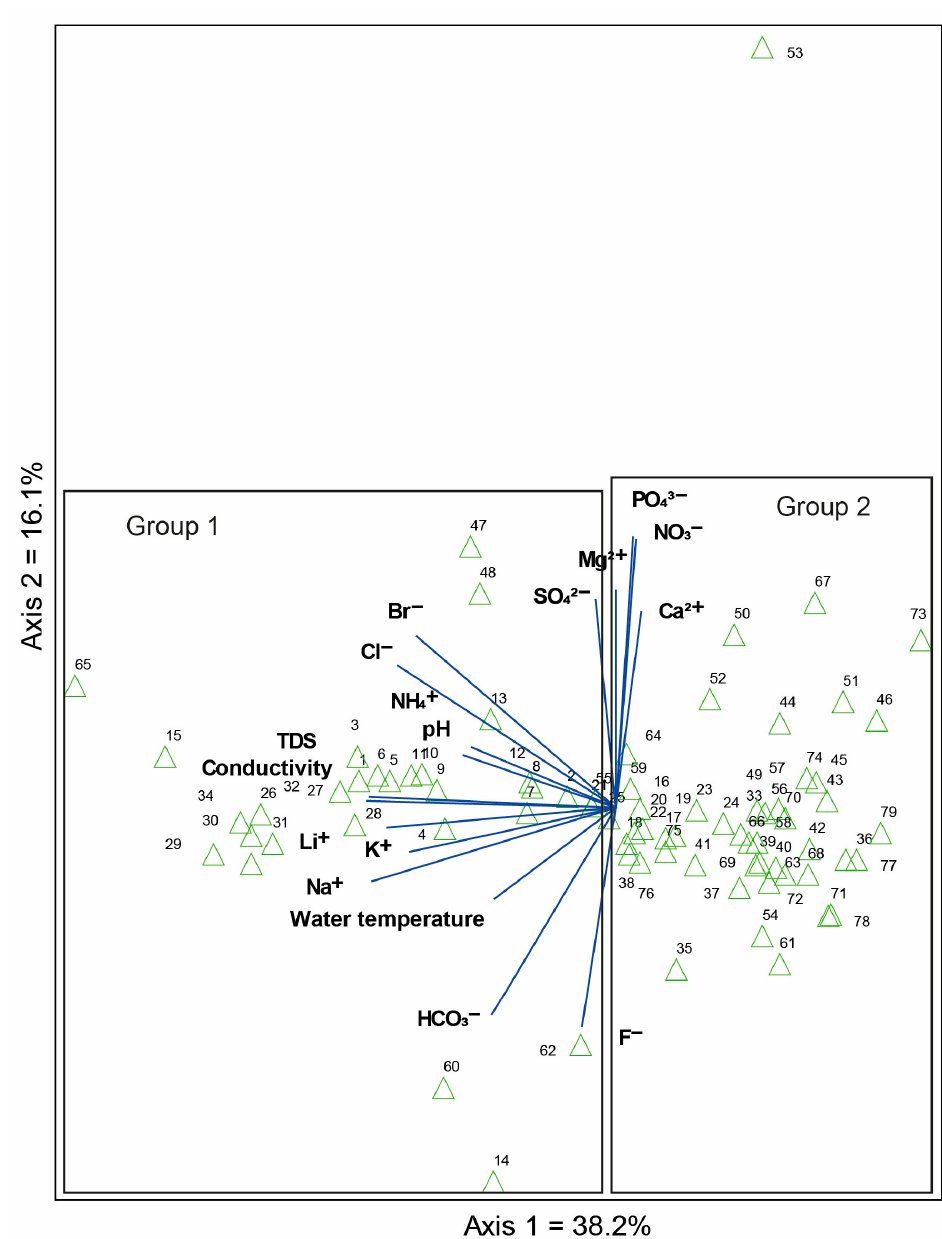
Figure 4. Ordination plot (F1 X F2) of a Principal Correspondence Analysis of the samples based on the physical and chemical variables. Green triangles represent the mineral springs studied and the spring number is presented in Table S1. The two groups of springs are presented.